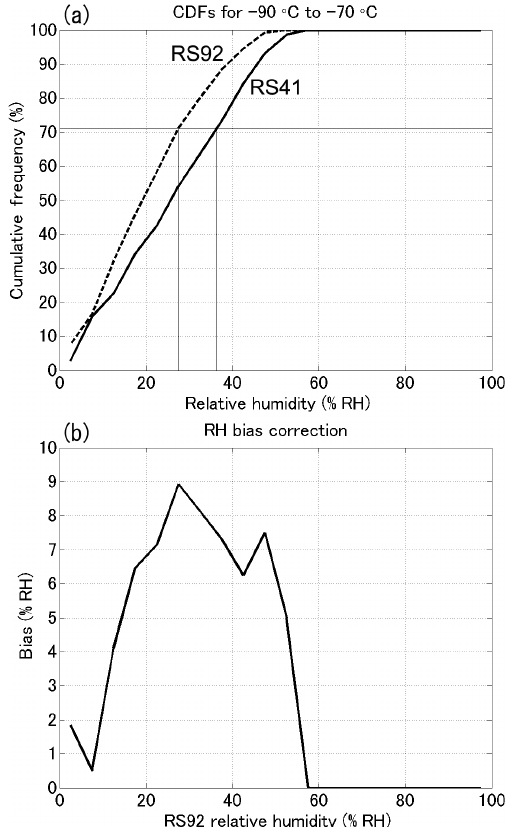
Figure 11. (a) CDFs of relative humidity for the RS92 (bold dashed line) and RS41 (bold solid line) data in the temperature range of –90 to − 70 ◦ C. The daytime data obtained during the MR15-04 cruise were used. Thin solid lines illustrate the CDF matching technique (see text). (b) Bias correction of relative humidity for the same tem- perature range.